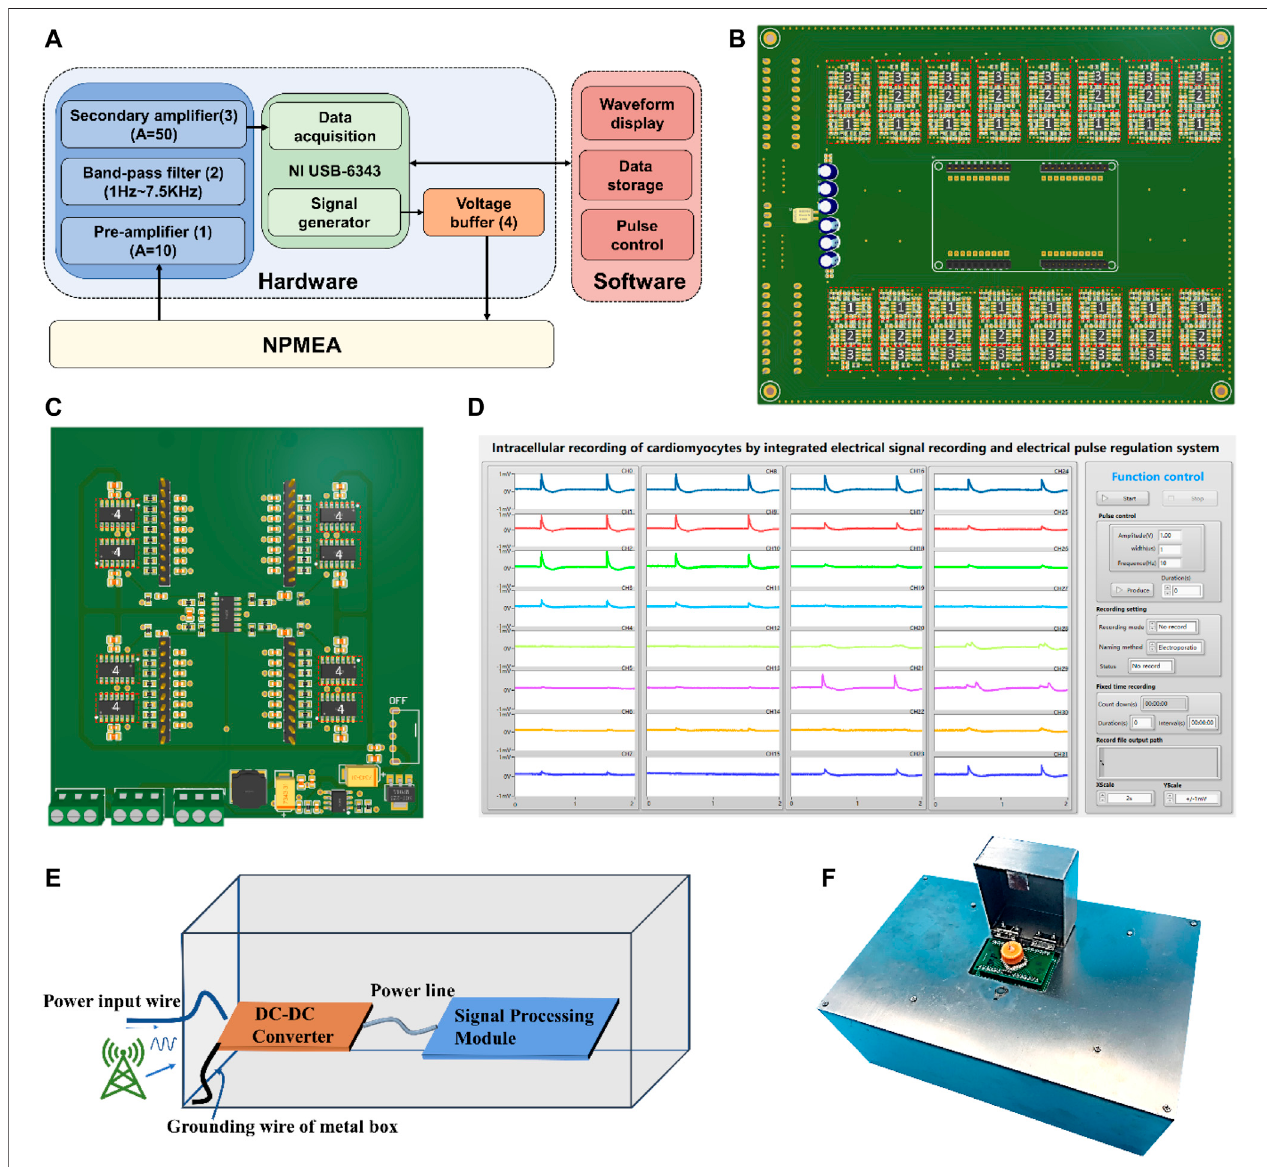
FIGURE 3 | Design of integrated electric signal recording and electric pulse regulating system. (A) The system structure of integrated electric signal recording and electric pulse regulating system: biosensor units, hardware module, and software module. The hardware module includes a signal processing module (blue), electroporation module (orange), and a DAQ module (green). The functions of the software module include waveform display, data storage and pulse control (pink). (Numbers in parenthesesindicate the corresponding labelled components in (B,C) ) (B) Signal processing module (integrated 32-channel signal processing circuit) diagram. (C) Electroporationmodule (integrated 32-channel electroporation circuit) diagram. (D) The software user interface of integrated electrical signal recordingand electricalpulseregulatingsystem. (E)